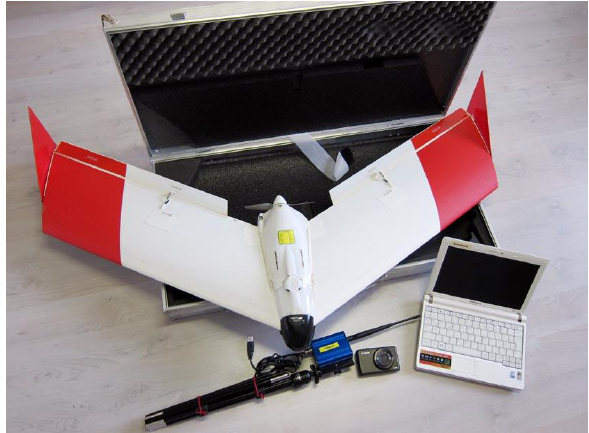
Figure 2 PAMS' SmartOne UAV with transport